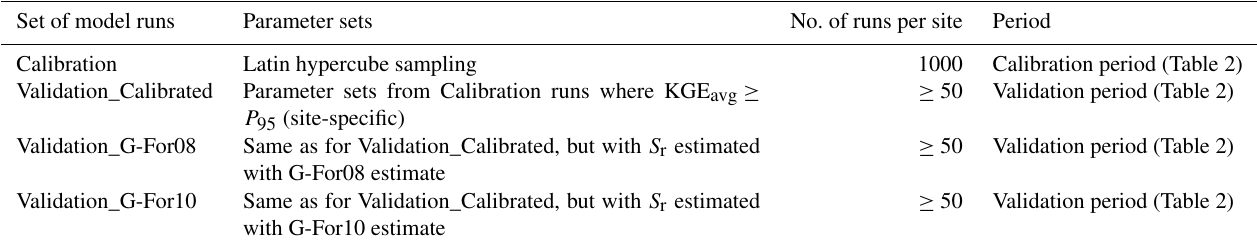
Table 3. Overview of calibration and validation runs of the FORHYTM model. Set of model runs Parameter sets No. of runs per site Period Calibration Latin hypercube sampling 1000 Calibration period (Table 2) Validation_Calibrated Parameter sets from Calibration runs where KGE avg ≥ ≥ 50 Validation period (Table 2)